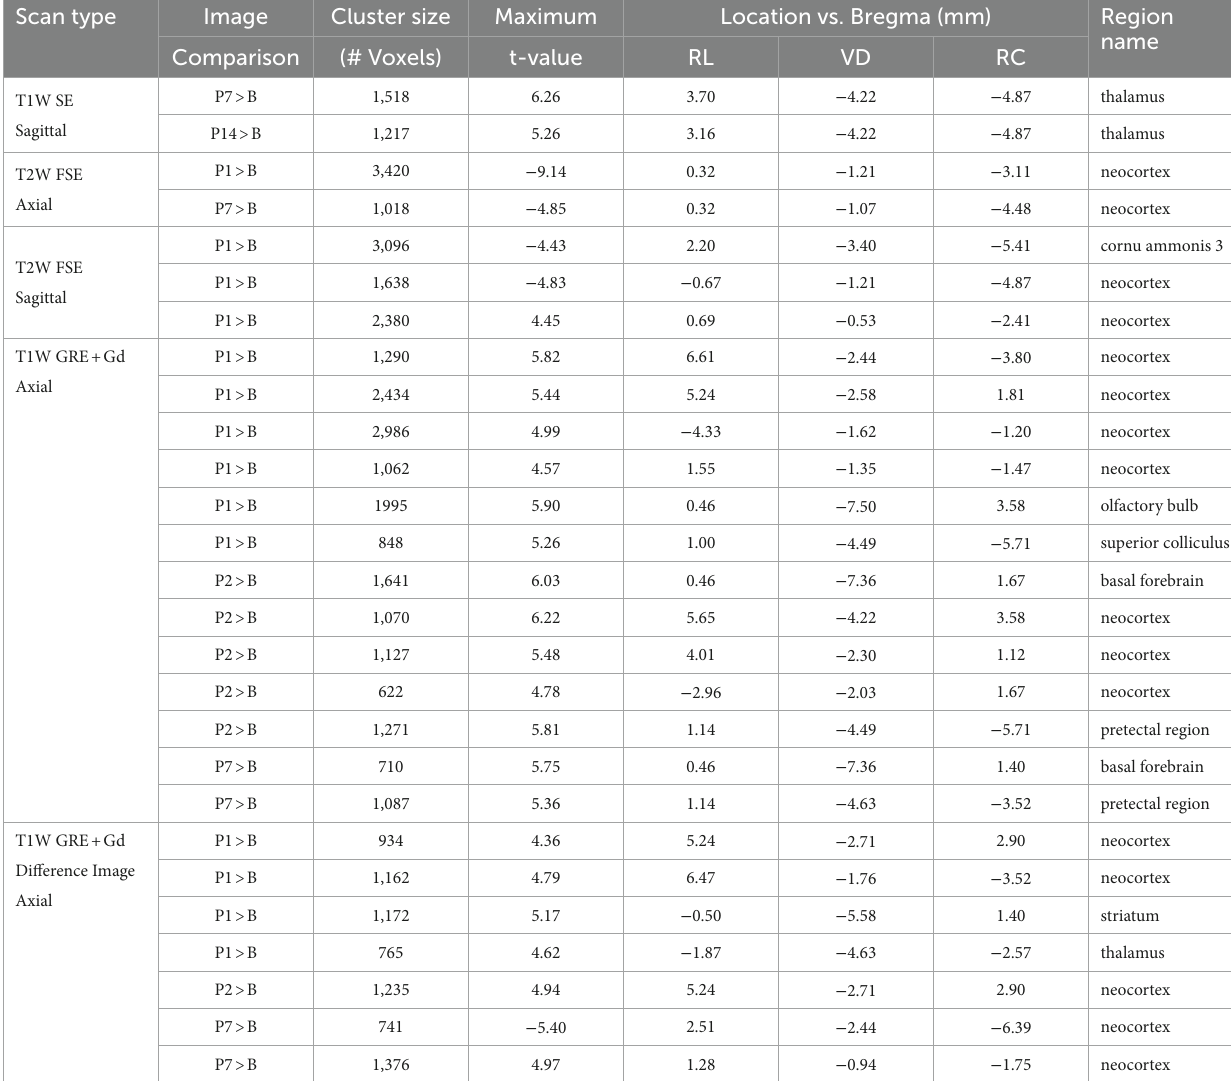
TABLE 5 Voxel-based morphometry group statistically significant